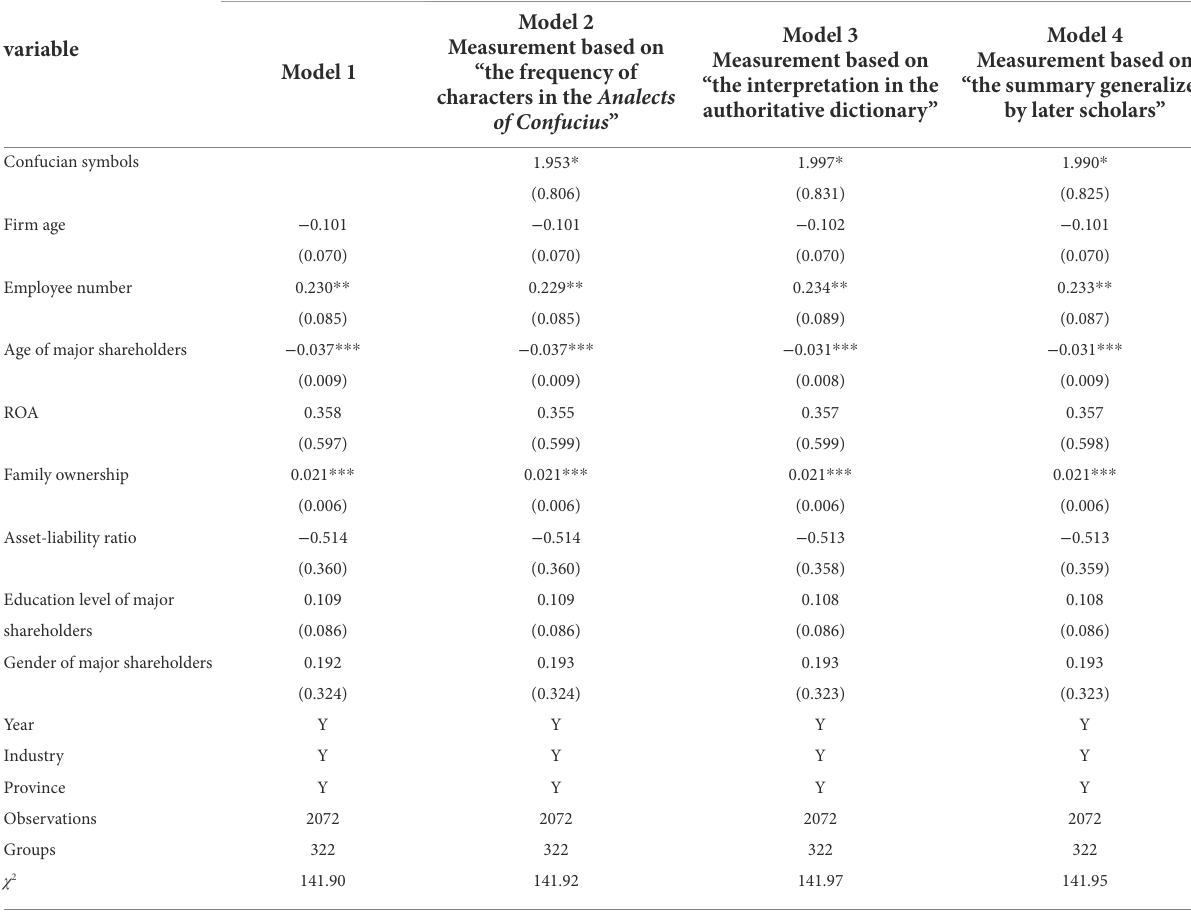
TABLE 5 The effect of Confucian symbols on corporate culture.